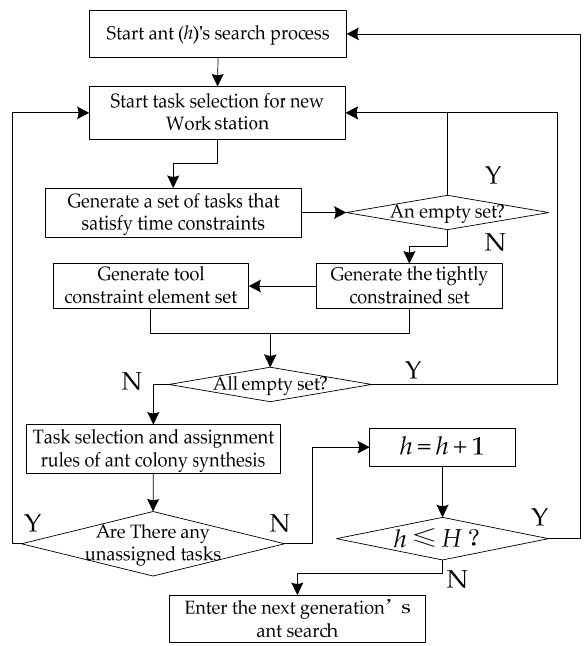
Figure 5. Ant colony optimization with heuristic rules.